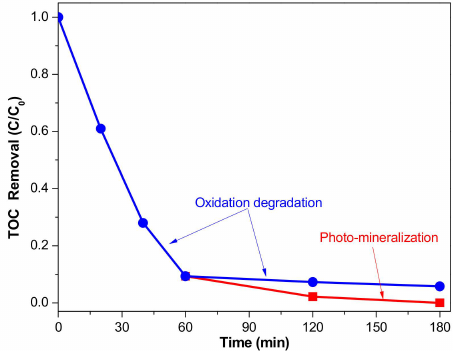
Figure 8. TOC removal profiles during phenol